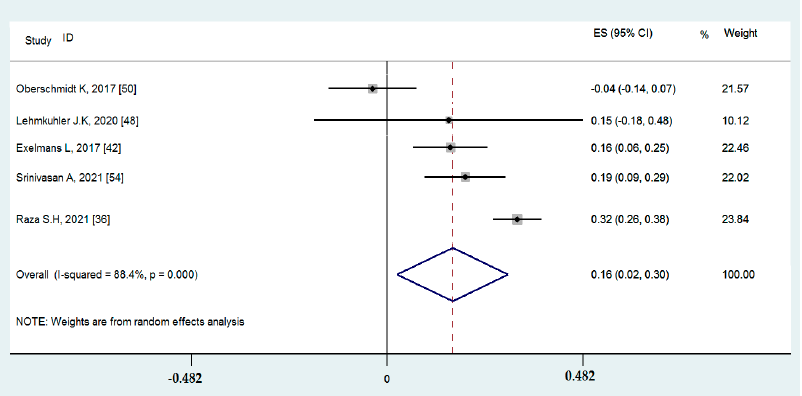
Figure 15. The forest plot displaying the estimated pooled Fisher’s z-score in the association between binge-watching and insomnia.